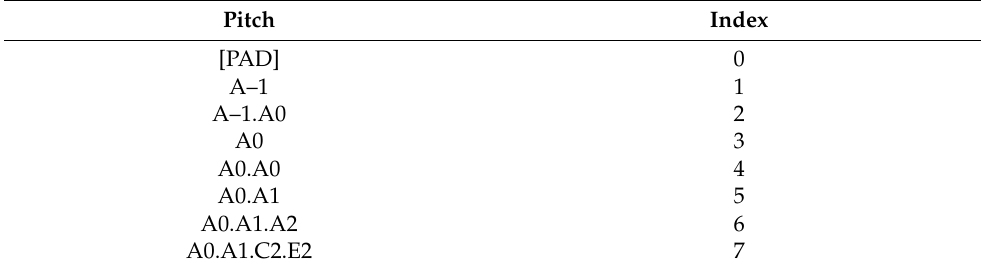
Table 2. The pitch-index lookup dictionaries for